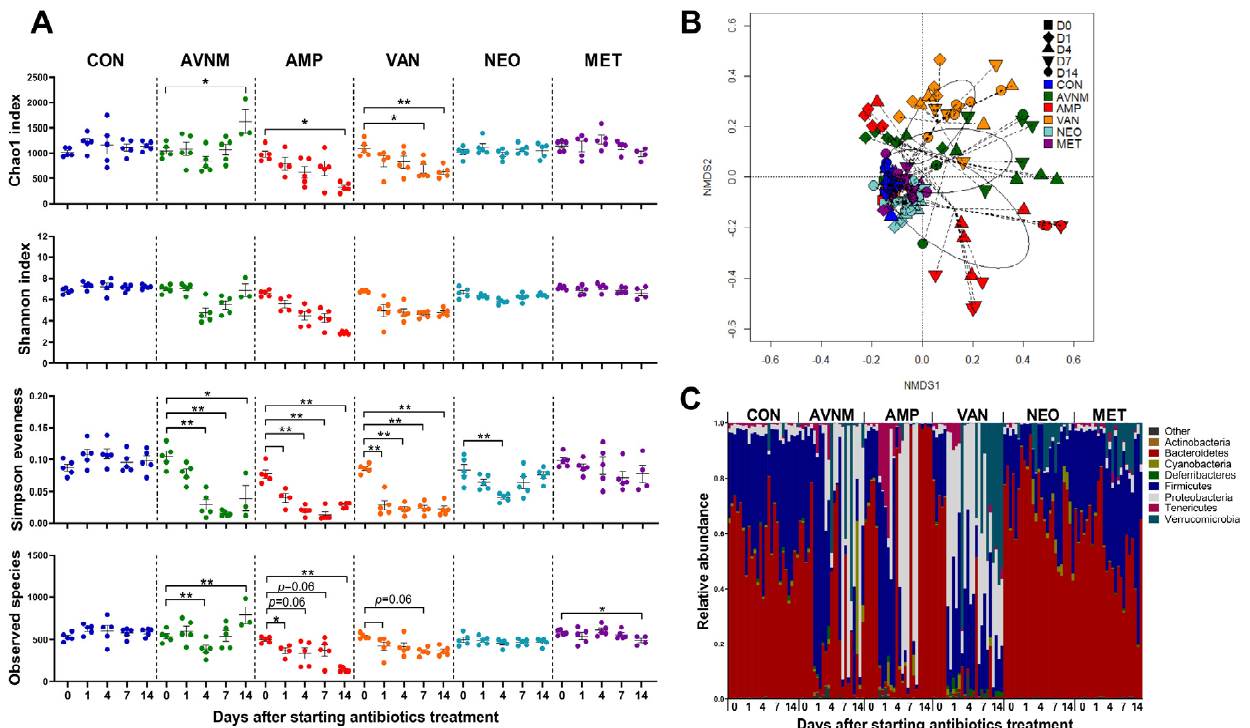
Figure 1. Effects of antibiotic treatment on fecal microbiota in mice. ( A ) Changes over time of alpha diversity in each antibiotic group. ( B ) NMDS plot of the fecal microbiota structure with Bray–Curtis distance. ( C ) Microbial composition comparison at phylum level. Data are expressed as the mean ± SEM. Asterisks indicate a statistically significant difference (* p < 0.05, ** p < 0.01; Mann–Whitney U test, CON, control; AVNM, mixture of ampicillin, vancomycin, neomycin and metronidazole; AMP, ampicillin; VAN, vancomycin; MET, metronidazole).